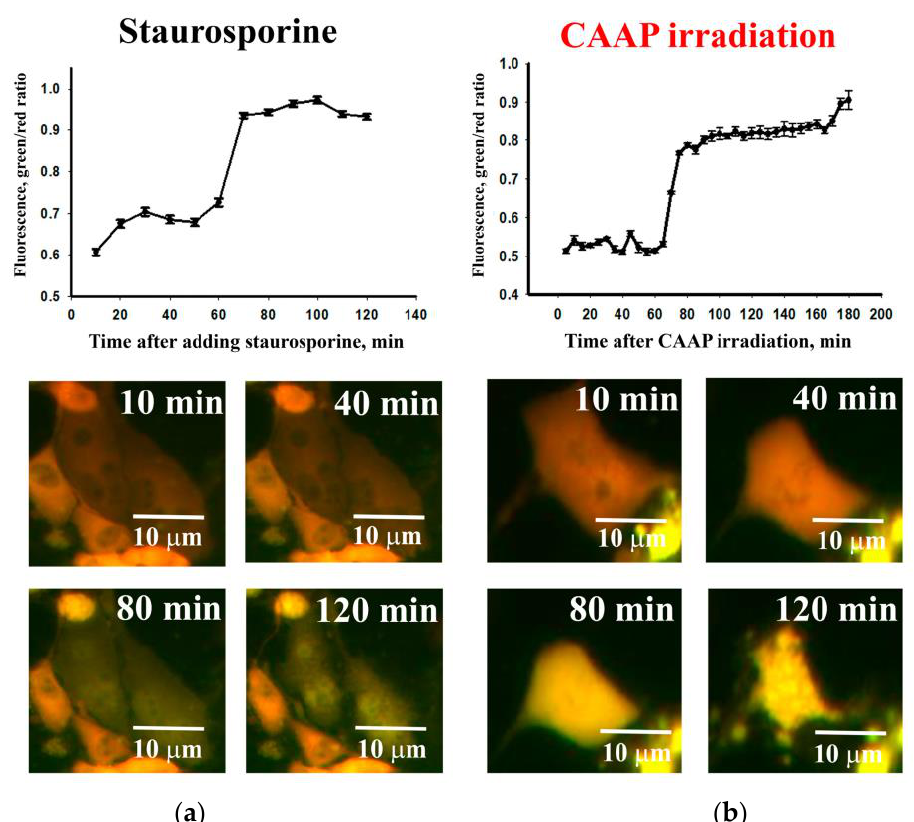
Figure 4. The analysis of MNNG/HOS cell death. Apoptosis was detected by a change in the ratio of fluorescence intensity in the green and red spectrum of the Casper3-GR protein—a sensor of caspase-3-dependent apoptosis: the dynamics of cancer cells death after staurosprine treatment ( a ); the dynamics of cancer cells death after 15 min exposure to CAAP ( b ).